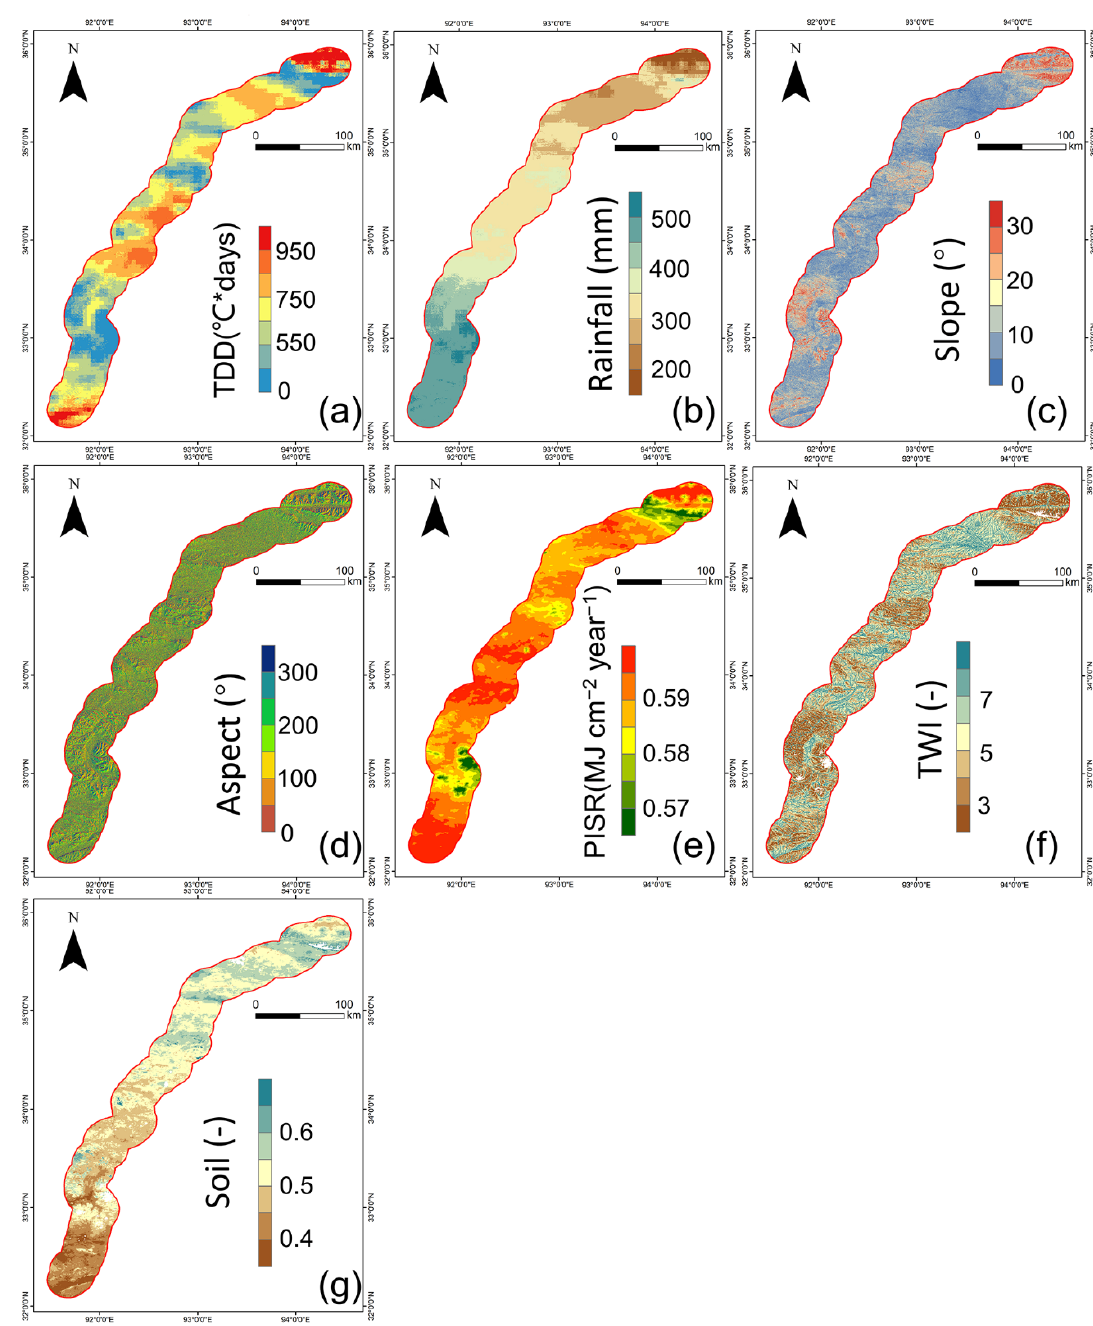
Figure 3. Thermokarst lake environmental factors for TLS modeling: ( a ) thawing degree days (TDD, °C * days); ( b ) rainfall (mm); ( c ) slope (°); ( d ) aspect (°); ( e ) potential annual incoming solar radiation (PISR, MJ cm − 2 year − 1 ); ( f ) topographic wetness index (TWI); and ( g ) fine soil content (Soil).